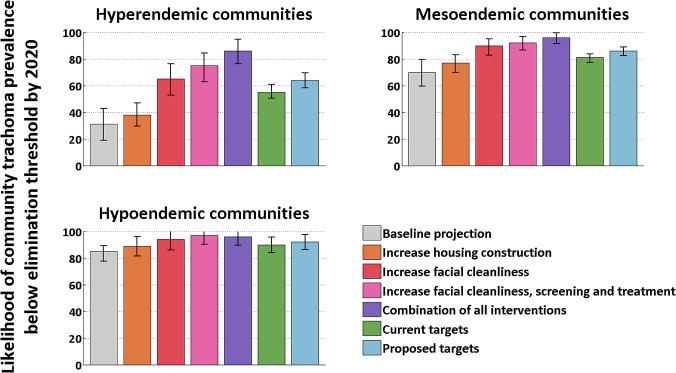
The aggregated likelihood of satisfying the trachoma control criteria by 2020 within a community under each of the considered future intervention scenarios, segregated by community endemicity.The values illustrated in the top left subplot indicate the significant increase in control likelihood that can be achieved by enhancing the intervention strategy and intensity in the worst affected communities.